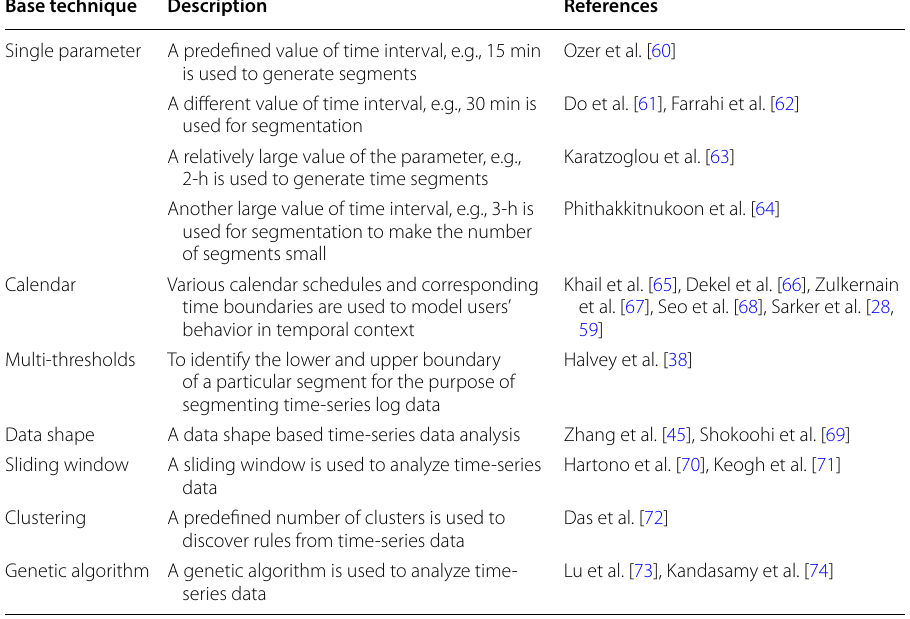
Table 2 Various types of dynamic time segments used in different applications Base